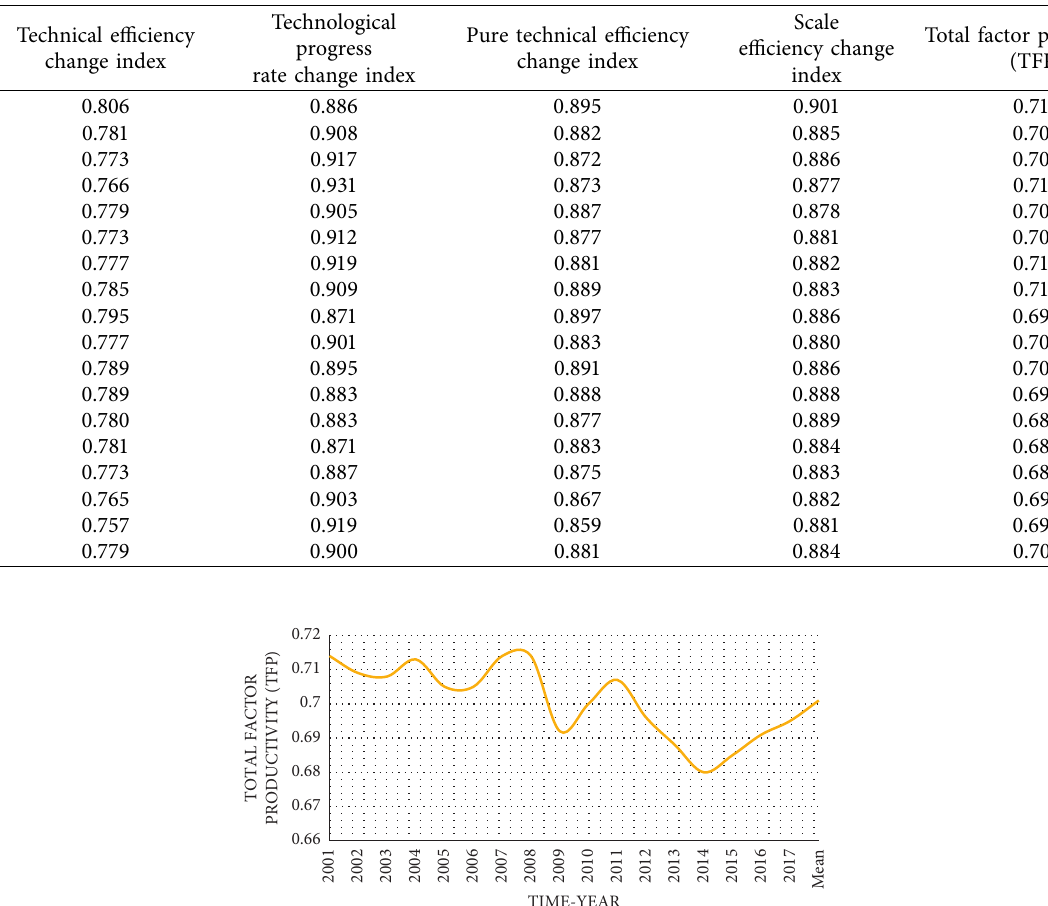
Table 1: 2001–2017 national average total factor productivity index and its decomposition.